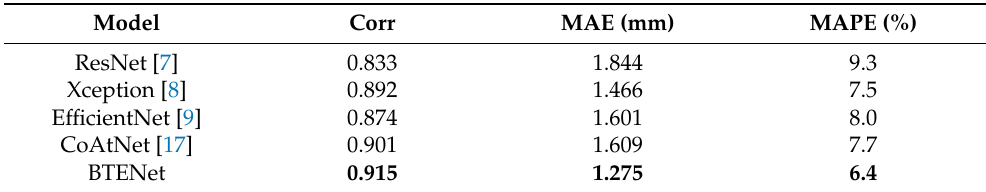
Table 3. Quantitative comparison of state-of-the-art methods on